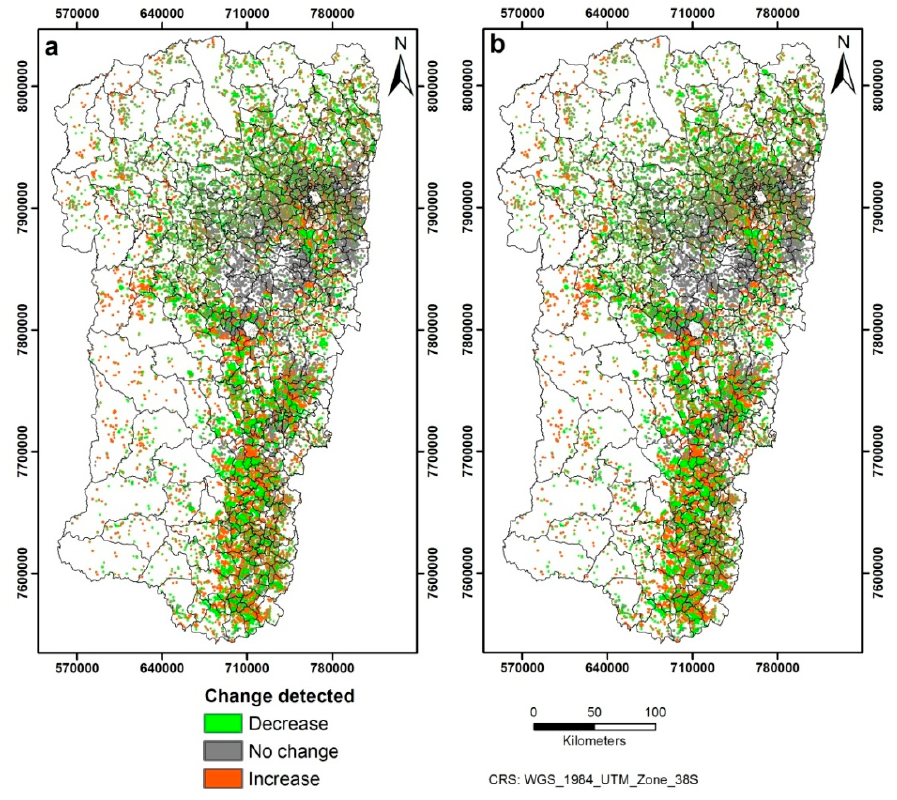
Figure 8. Change detection of suitability models. ( a ) 2015–2014, ( b ) 2016–2015.